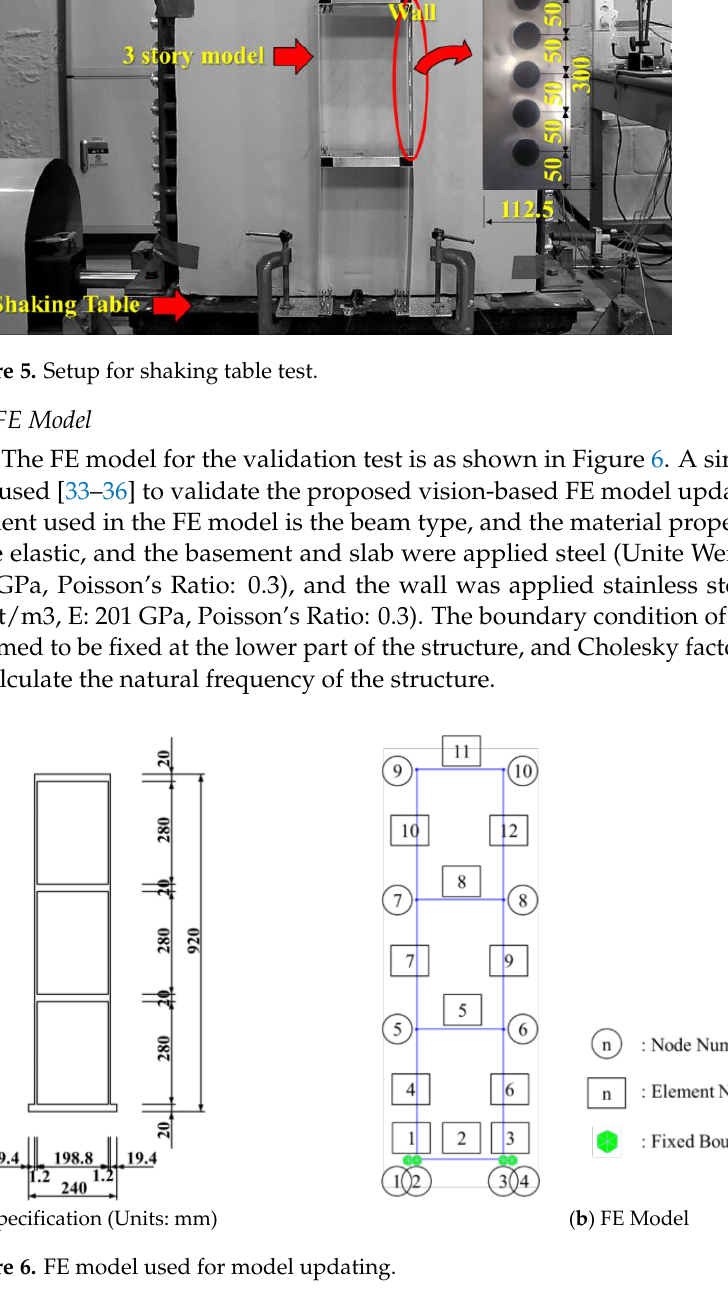
Table 1. Mesh sensitivity analysis result.